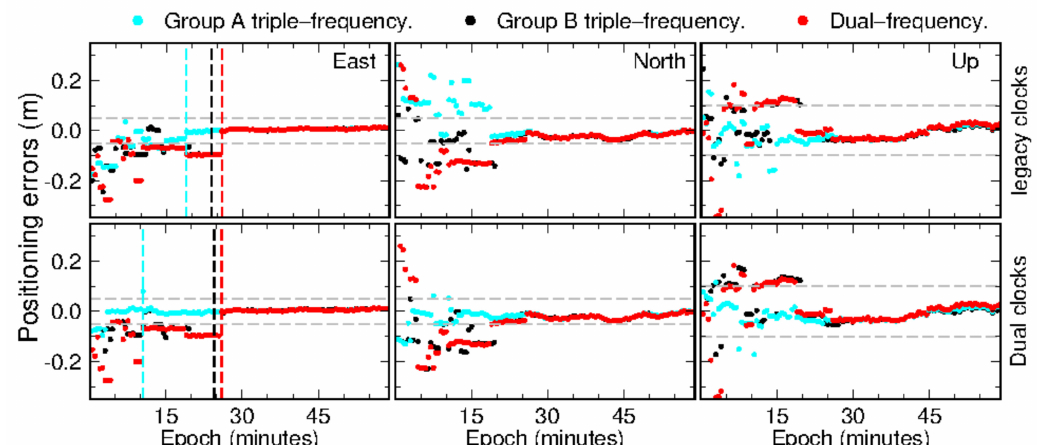
Figure 3. One-hour PPP-AR solutions of SAS2 on UTC 20:00, day 183 of 2020. The dashed gray lines are ± 5 cm for horizontal directions and ± 10 cm for vertical direction, while the vertical dashed lines mark the convergence epoch of each